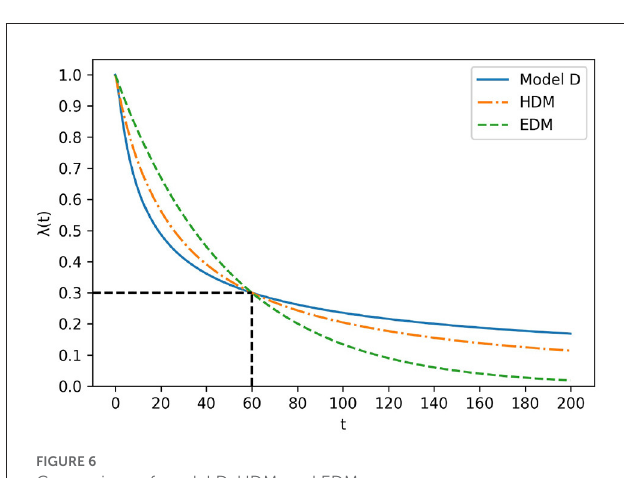
FIGURE4 The results of our first author’s discount function.